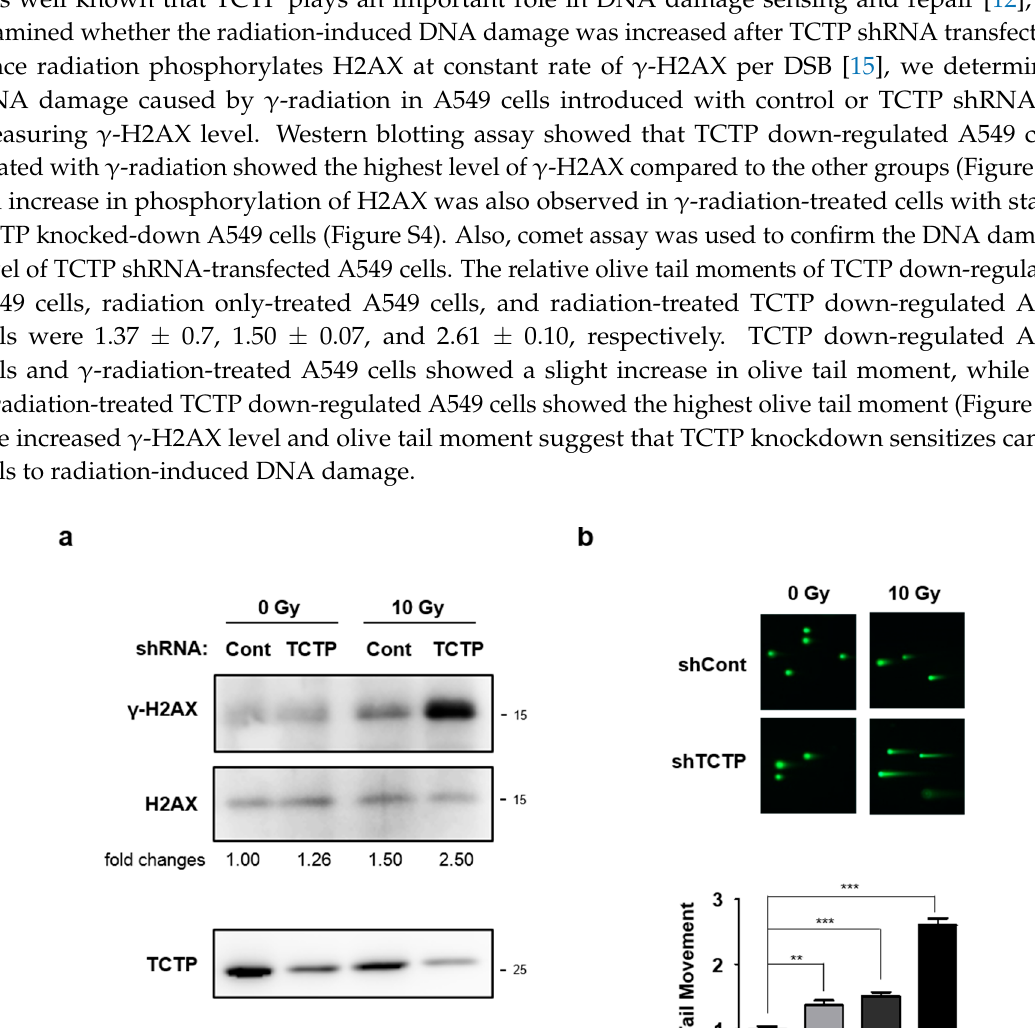
Figure S7. Bars represent the means ± SEM. * p < 0.05, ** p < 0.01, *** p < 0.001 by two-way analysis of variance.